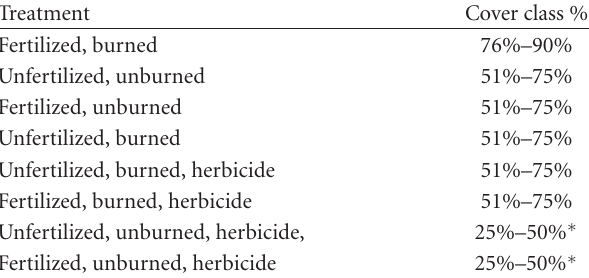
Table 2: Percent of ground cover (first two posttreatment years) for all treatment combinations, cherokee ridge and sweet union research sites combined, east Texas, USA. ∗ significantly di ff erent at P = .1 from analysis of various test proc GLM (SAS, ver